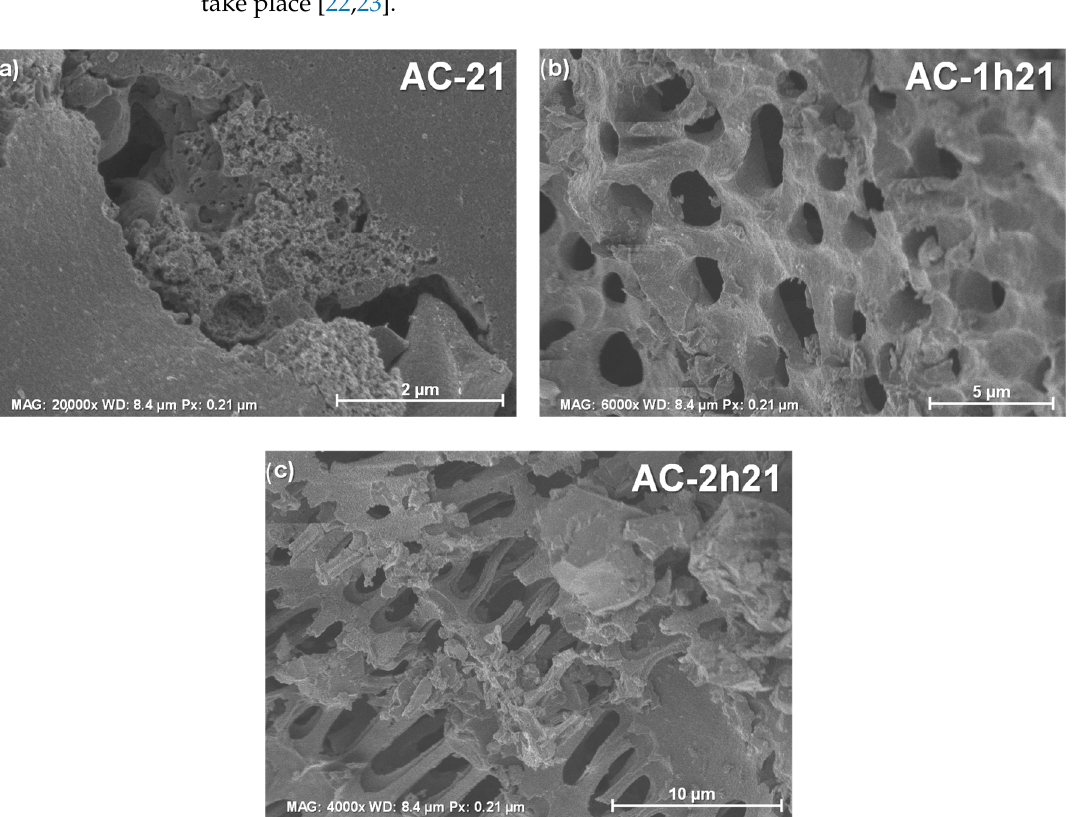
Figure 5. SEM images of the carbon samples incubated for 21 days; ( a ) AC-21, ( b ) AC-1h21, and ( c ) AC-2h21.